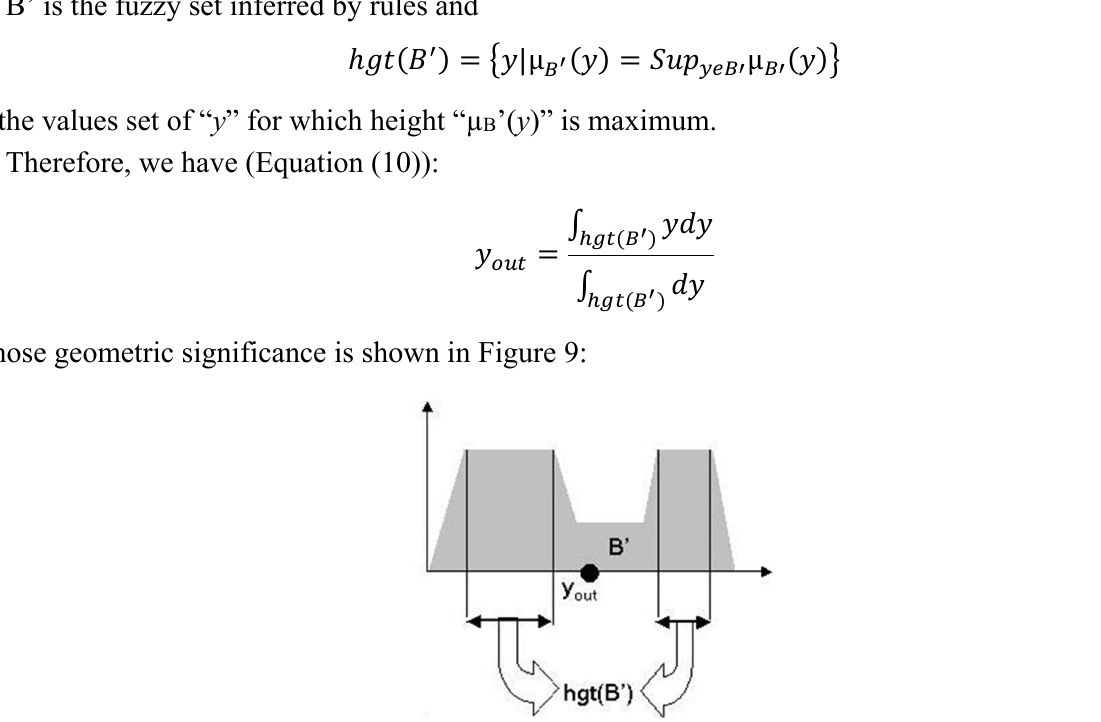
Figure 9. Geometric significance of the middle of maximum defuzzification